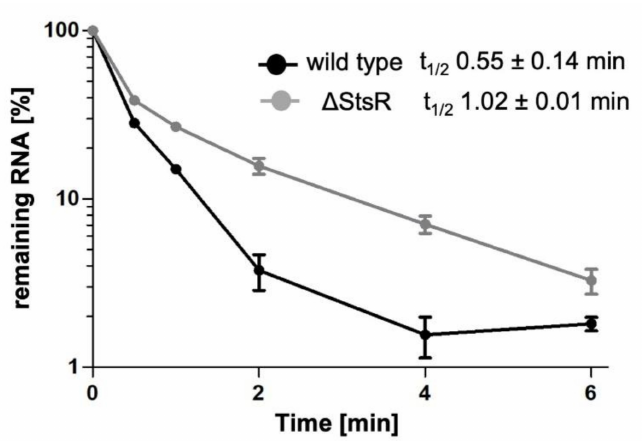
Figure 7. StsR decreases the half-life of rpoE mRNA. Rifampicin was added to cultures in the exponential growth phase to inhibit initiation of transcription. RNA was isolated at several time points and rpoE mRNA levels were quantified by real time RT-PCR and plotted against time. The values represent the average from three independent cultures, and the standard deviation is